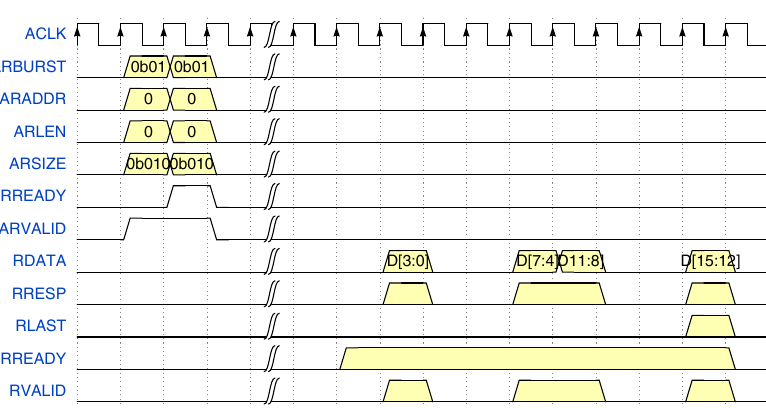
Figure 10. AXI burst mode timing diagram in read